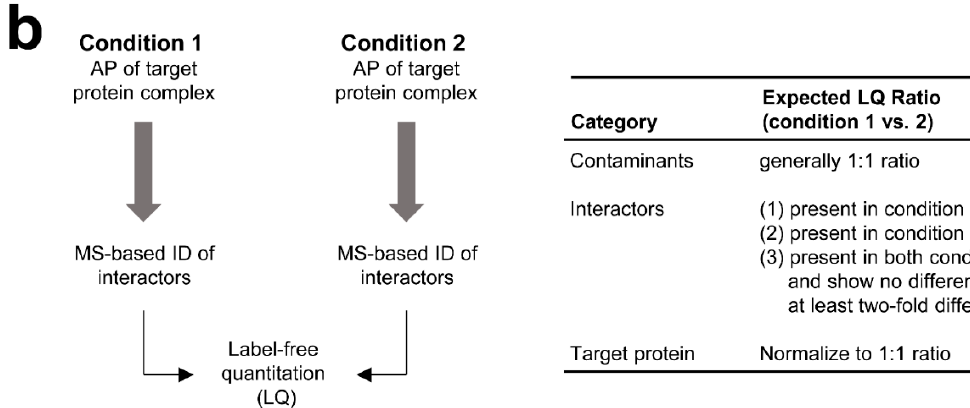
Figure 2. Application of MS-based label-free quantitation (LQ) to study protein complexes. ( a ) The MS-based LQ to identify the contaminants or non-specific interactors is shown. The protein complex eluent of endogenous ( left panel ) or ectopically ( right panel ) expressed target protein is collected by affinity purification (AP). In addition, the corresponding eluent of negative control is collected by means of AP. The eluents are subjected to enzymatic digestion and subsequent MS analysis (Figure 1). The MS data of sample and negative control are compared by LQ and the anticipated results are shown in the bottom panel; ( b ) The MS-based LQ to identify the differential protein interactions is shown. The protein complex of endogenous or ectopically expressed target protein is eluted from two biological conditions by means of AP. It is important to maintain the negative controls as described in Figure 2a. The eluents are subjected to enzymatic digestion and subsequent MS analysis (Figure 1). The MS data obtained from conditions 1 and 2 are compared by LQ and the anticipated results are shown in the right panel. The figure is drawn based on the concepts described in multiple studies [4,20,31,45,47–51].